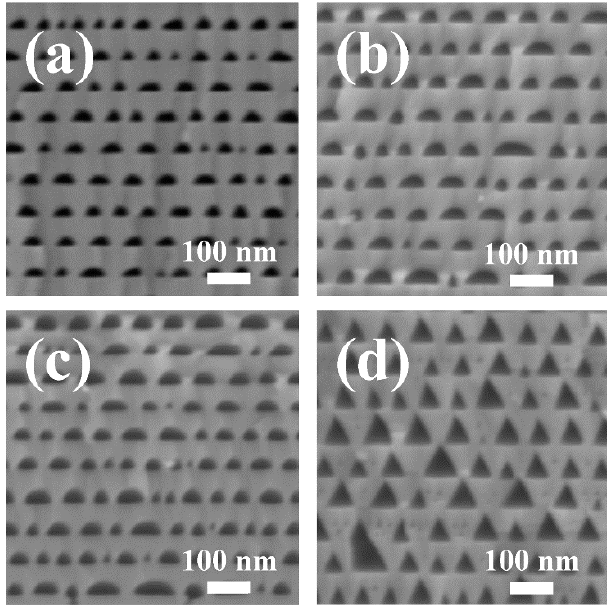
Figure 2. Cross-sectional SEM images of porous AlGaN stacks etched in: ( a ) 15 M HNO 3 at 12 V; ( b ) 15 M HNO 3 at 15 V; ( c ) 15 M HNO 3 at 18 V; ( d ) 1 M KOH at 15 V.